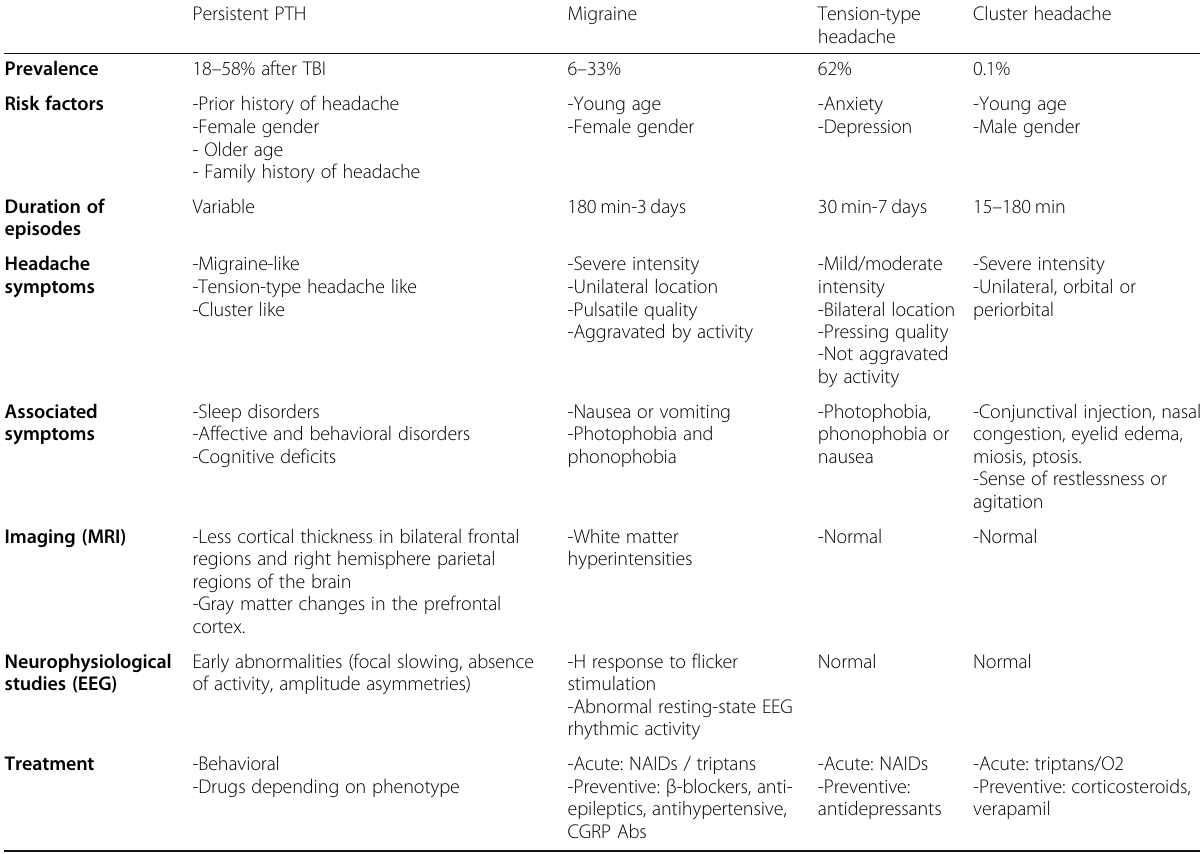
Table 1 Comparison of the characteristics between persistent PTH and primary